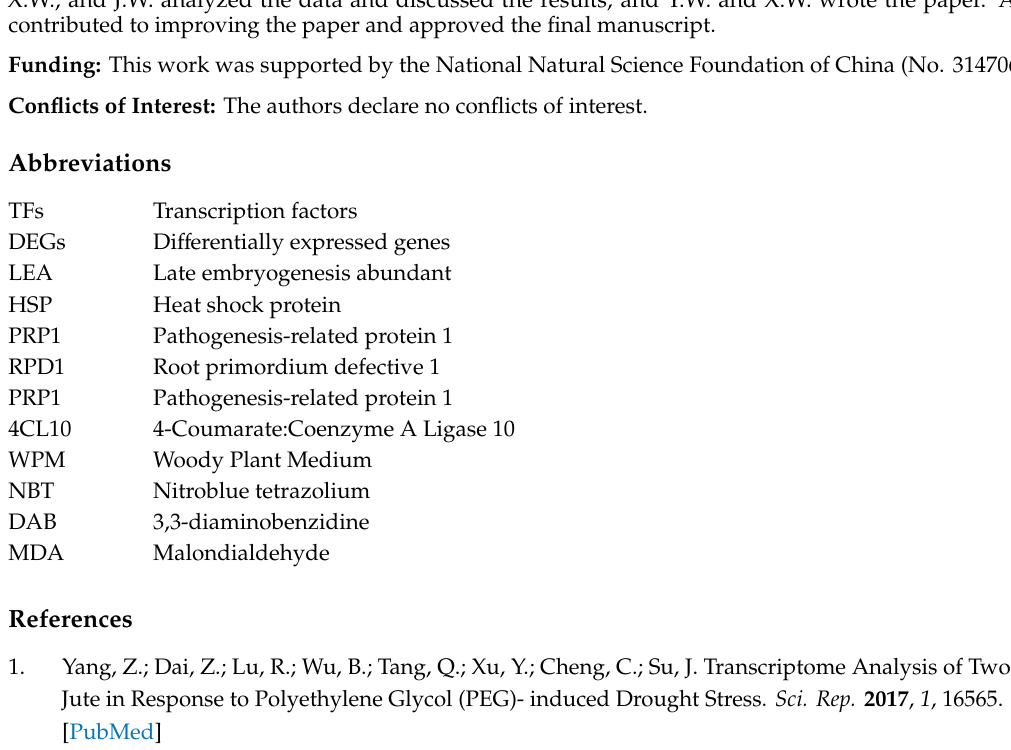
3071 / s1. Table S1: List of primers used for construction. Table S2: List of primers used for qRT-PCR experiments. Table S3: List of primers used for ChIP. Table S4: Di ff erential expression gene data. Figure S1: Transcriptome data analysis. ( a ) The correlation coe ffi cients between the di ff erent samples; ( b ) volcano plot of the di ff erentially expressed genes; ( c ) functional analysis of the di ff erentially expressed genes using GO term annotations. Author Contributions: Y.W. and D.Z. designed the research; X.W. and J.W. performed the research; Y.W., D.Z., X.W., and J.W. analyzed the data and discussed the results; and Y.W. and X.W. wrote the paper. All